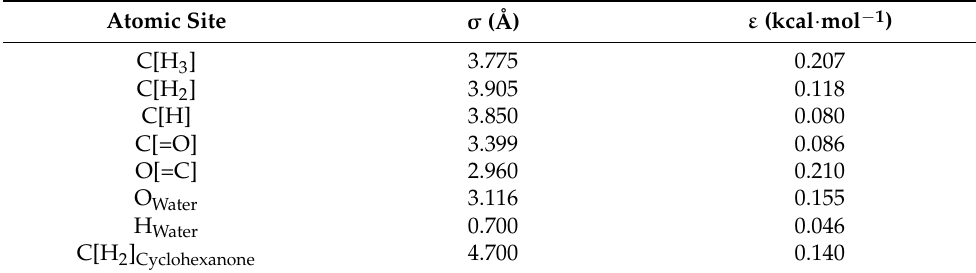
Table 1. Van der Waal’s parameters used for solvent atomic sites in this